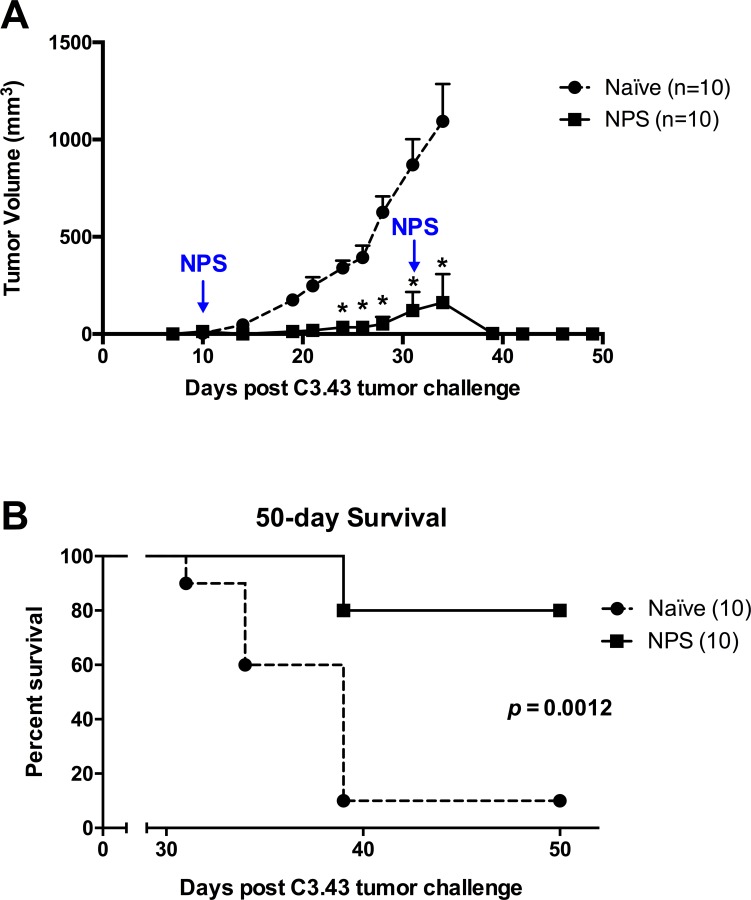
NPS treatment of primary tumors results in significant levels of tumor clearance, enhanced survival, and is effective during multiple applications.Groups of 10 mice were s.c. challenged with C3.43 tumors. 10-days post tumor challenge mice were given NPS (3 pps, 30kV/cm) treatment at the tumor site. Mice with recurring tumors received a second treatment on day 31 (A) Mean tumor volume (±SEM) of untreated and NPS treated mice (*p<0.05, unpaired students t-test at each time point). Volume measurements of untreated group displayed until there was a loss of 3 or more mice within the group due to euthanasia endpoints met (B) 50-day survival curve of groups with no treatment (naïve, median survival 39 days) or NPS treatment (NPS) (p<0.0012, Mantel-Cox Log Rank test). Data are representative of 2 independent experiments.